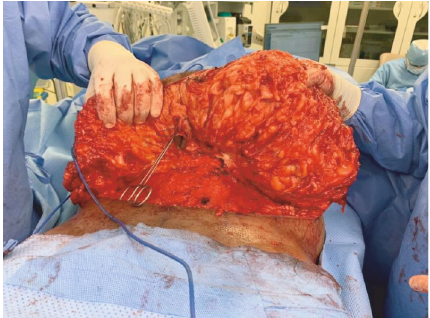
Figure 2: Intraoperative. Raised fl ap.